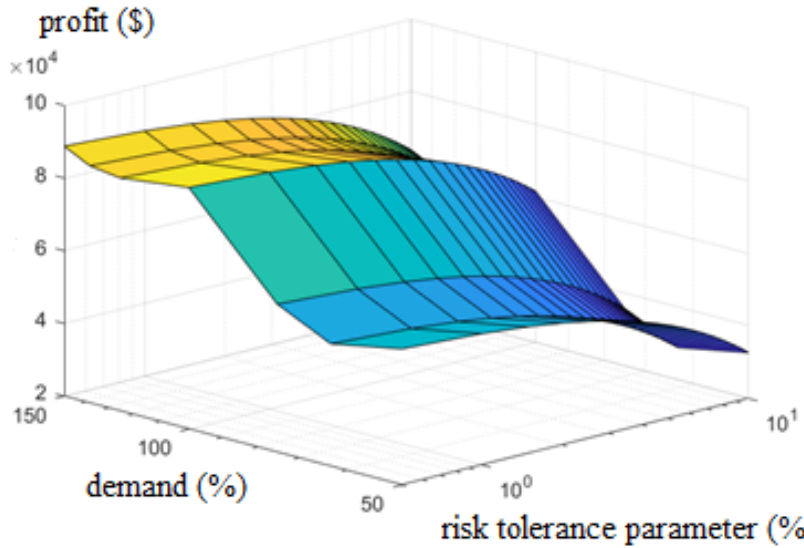
Figure 5. Profit diagram of bidding demand in Case 2.